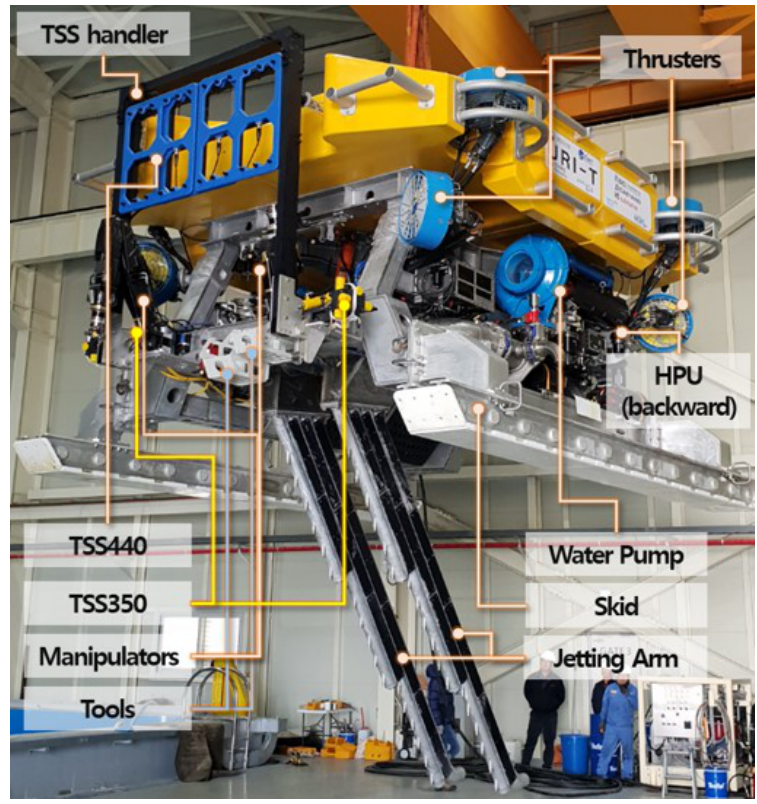
Figure 1. URI-T, an underwater cable burying